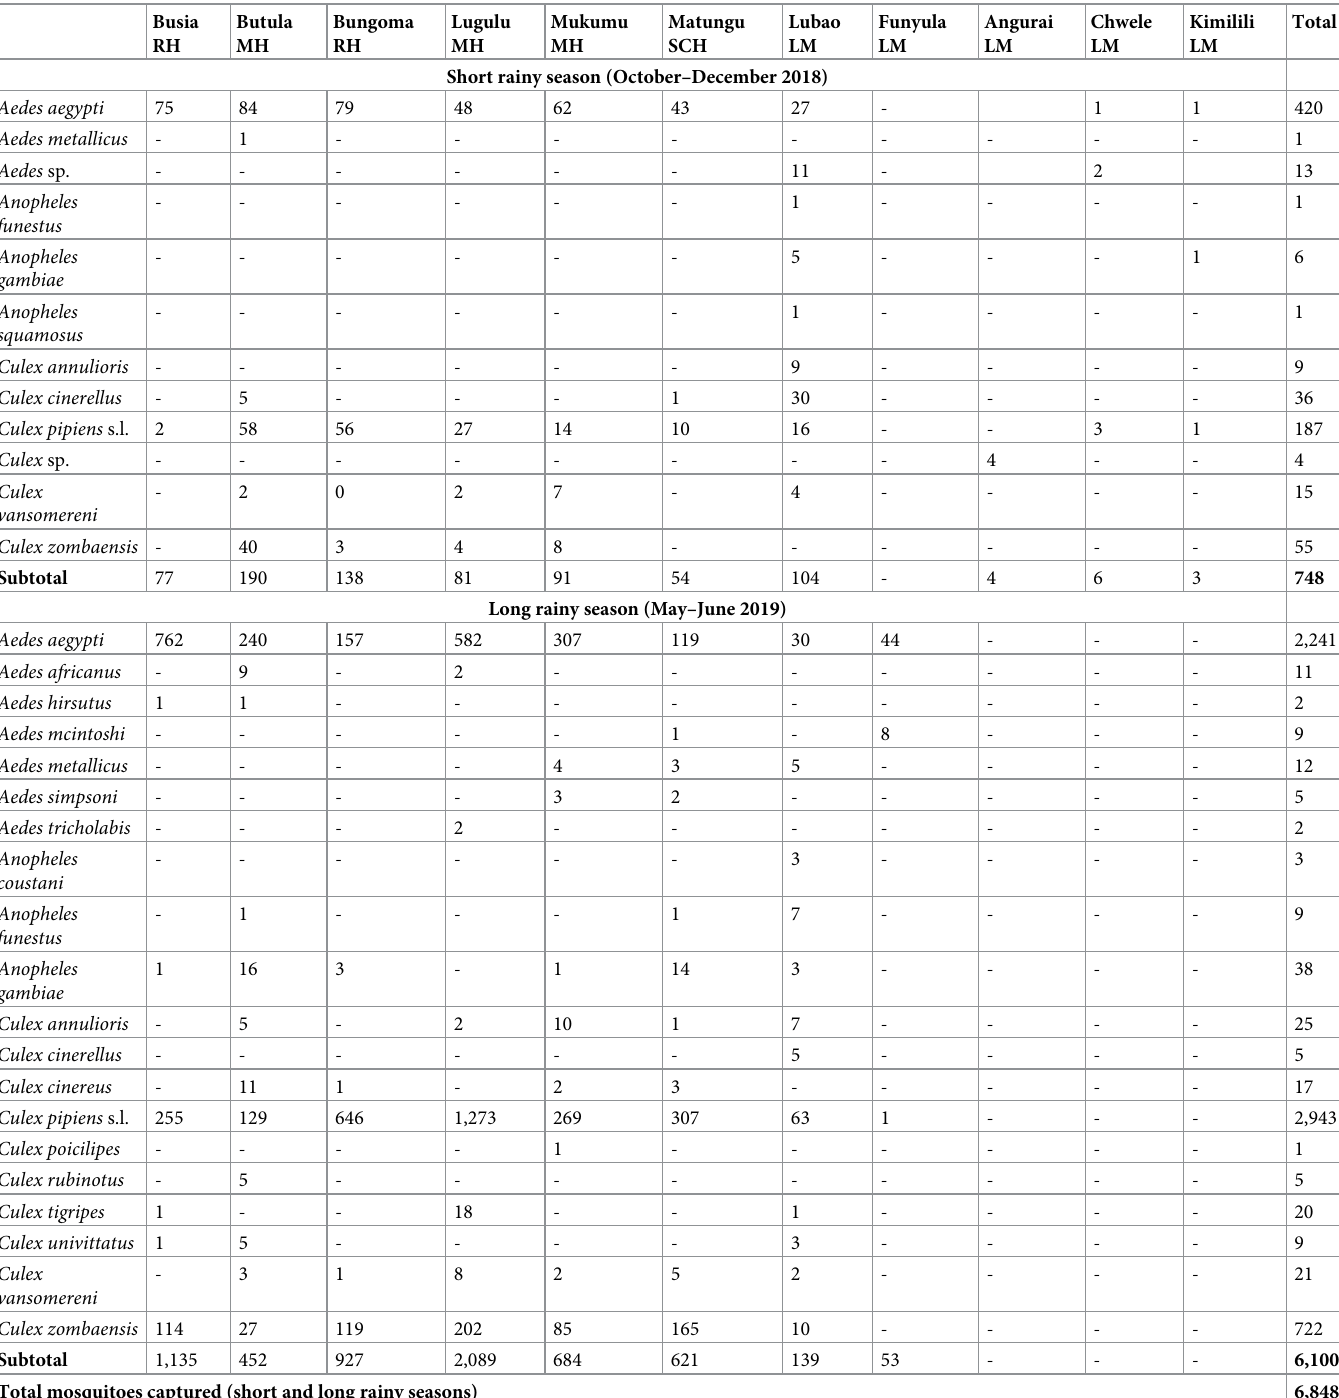
Table 2. Summary table of mosquitoes caught at the sampling sites during the long and short rainy seasons in western Kenya. Busia RH